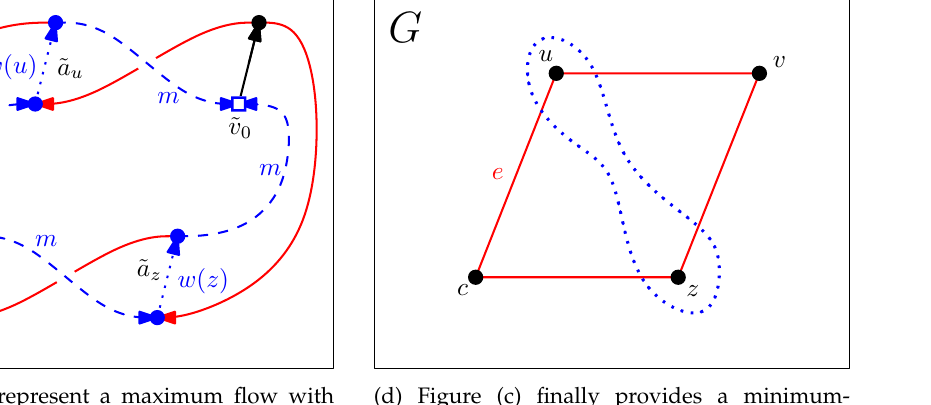
(d) Figure (c) finally provides a minimum- weight edge cut { ˜ a u , ˜ a z } . Transferring this result back to G , we get the wanted minimum-weight ( c, v ) -separator { u, z } .